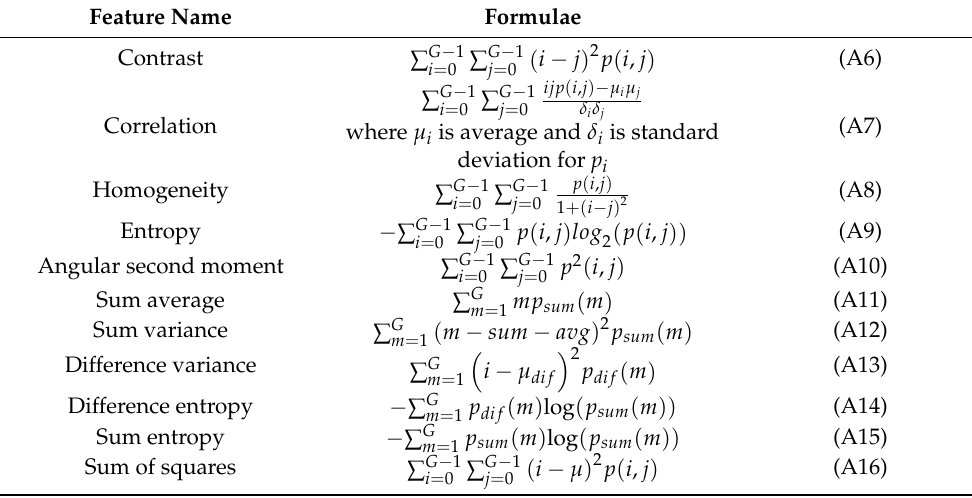
Table A2. Formulae to calculate gray level co-occurrence matrix from the gray-scale image.